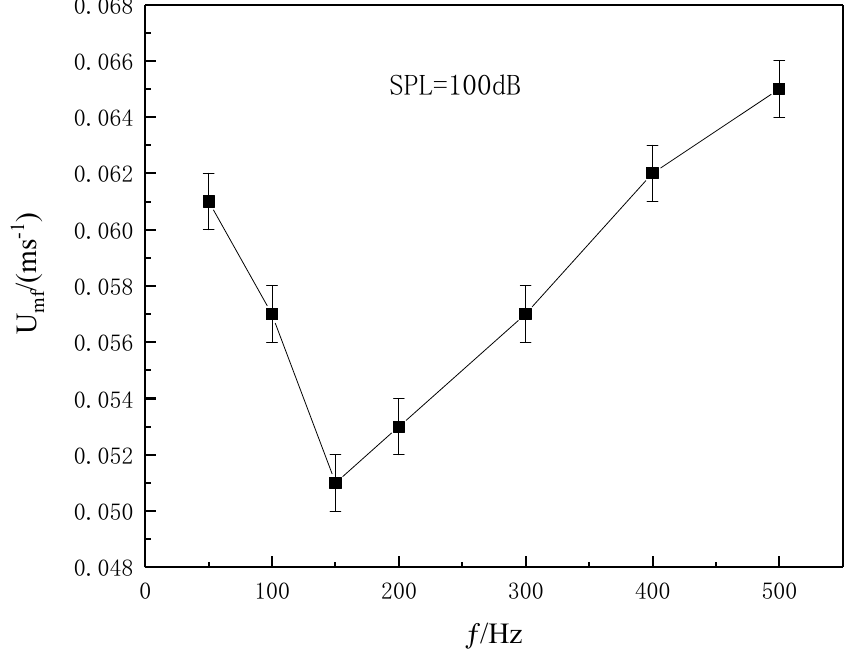
Figure 7. Influence of the frequency on the minimum fluidization velocity.